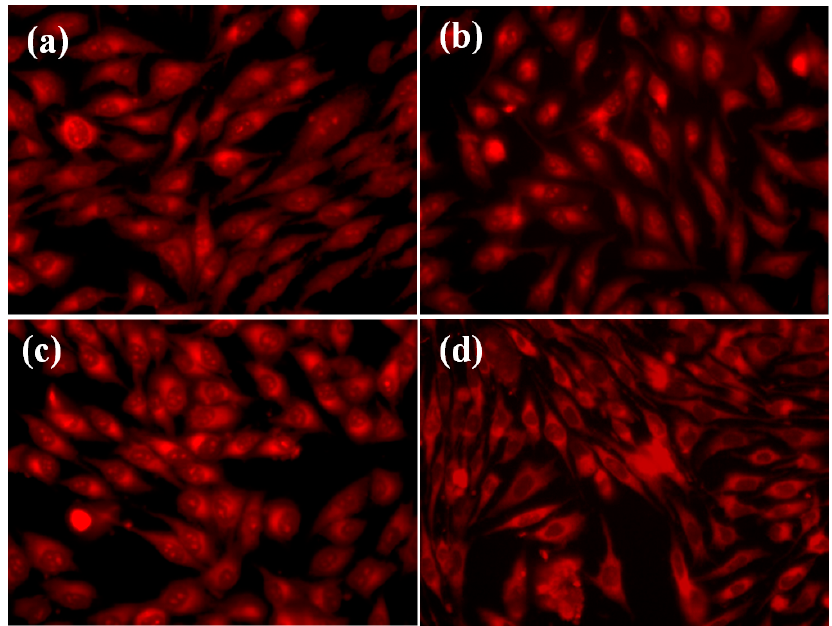
Figure 7. Fluorescence microscopy images revealing the growth of cultured human cells in the presence of the 3D matrices: ( a ) 3D-1:1; ( b ) 3D-1:2; ( c ) 3D-1:3, and control (standard conditions) ( d ).